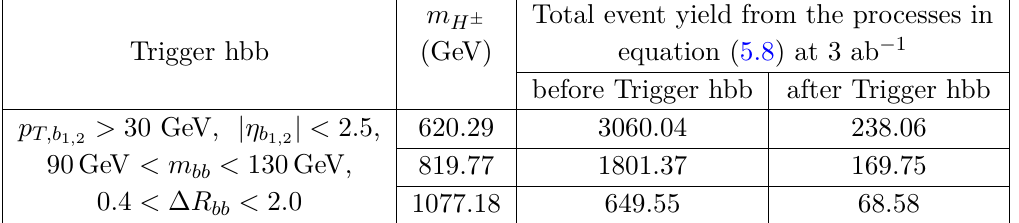
> 100 GeV and | η | < 2 . 5 ) and T, e χ ± 1 e χ ± 1